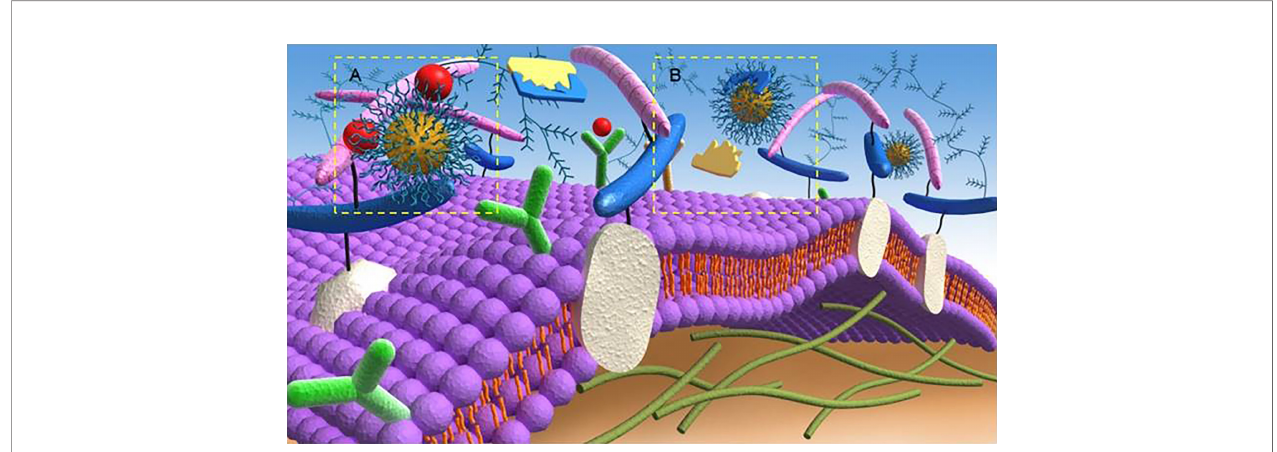
FIGURE 1 | Anti-angiogenic mechanisms of targeting (A) angiogenic growth factors and (B) proteolytic enzymes of the extracellular matrix by anti-angiogenic strategies. Reproduced with permission (42). Copyright 2018, Ivyspring International